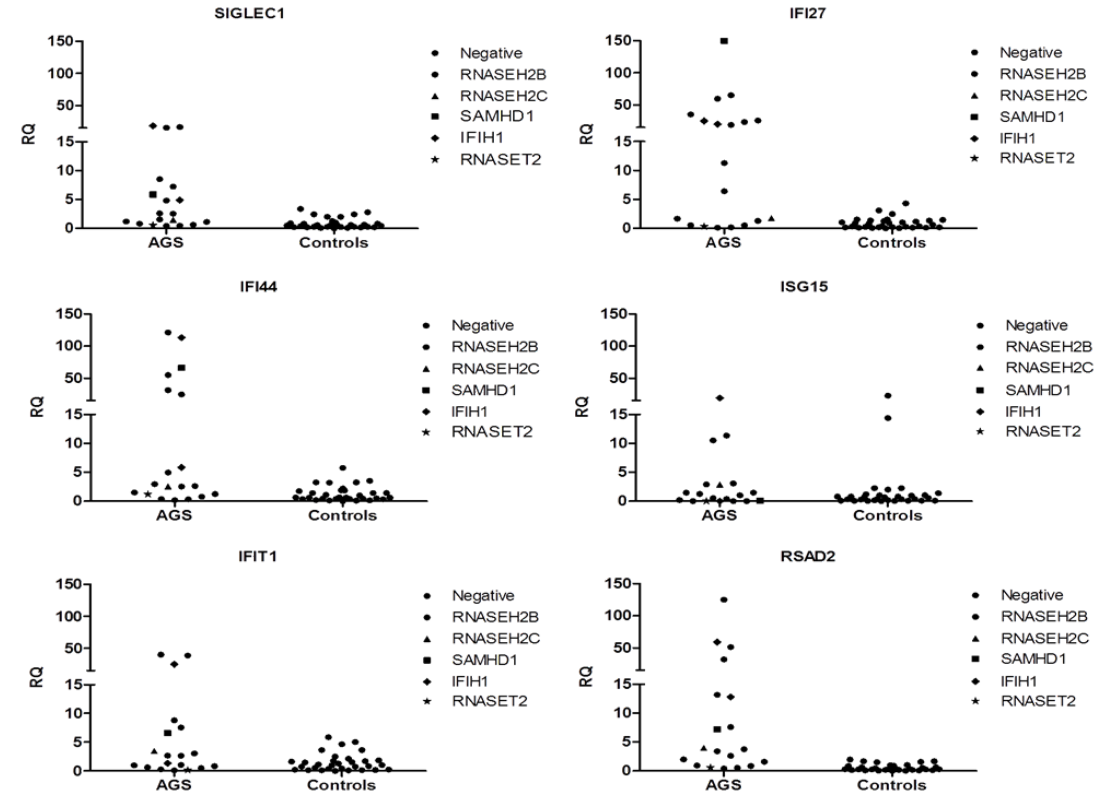
Figure 3. Median fold expression of six interferon-stimulated genes ISGs IFI27 , IFI44 , IFIT1 , ISG15 , RSAD and SIGLEC1 according to the genotype of 18 AGS patients and controls.